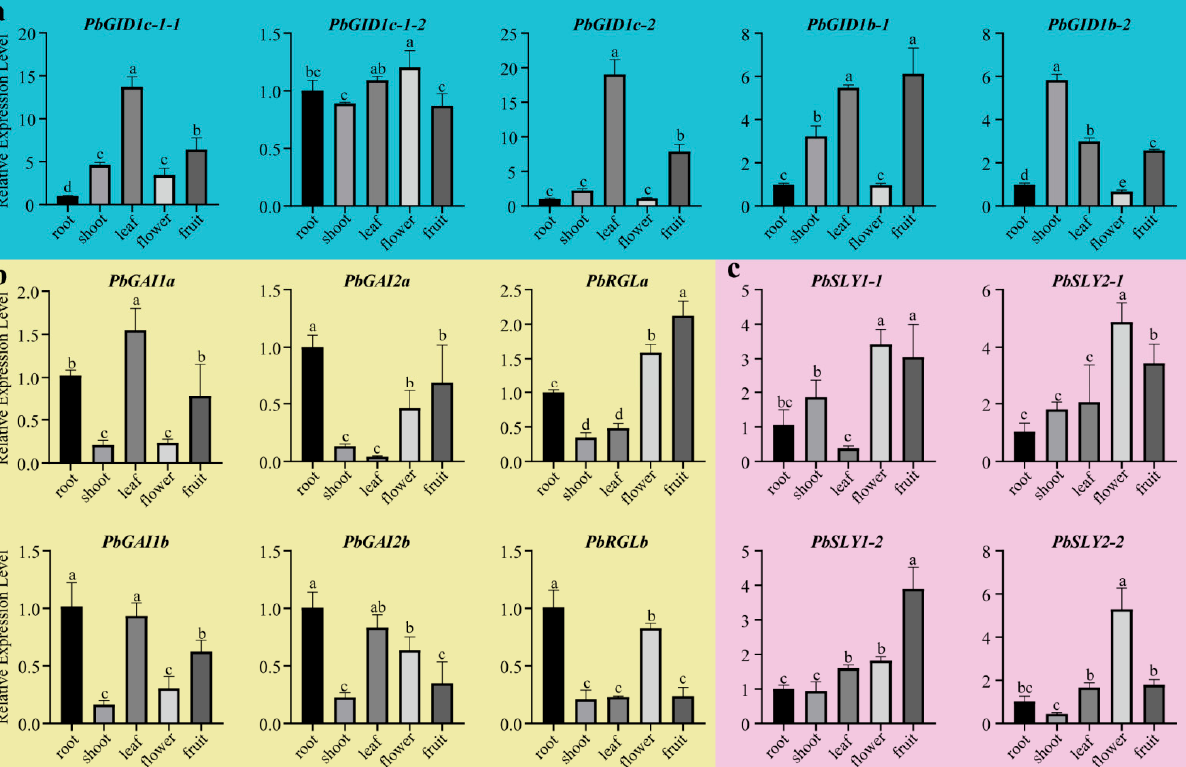
Figure 6. Expression profiles of PbGID1 , PbDELLA , and PbSLY family genes in different tissues of ‘duli’ pear ( Pyrus betulifolia Bunge). ( a ) Expression profiles of PbGID1s (shaded blue). ( b ) Expression profiles of PbDELLAs (shaded yellow). ( c ) Expression profiles of PbSLYs (shaded lilac). Quantitative RT-PCR was carried out using total RNA isolated from different tissues as indicated. PbACTIN was used as the reference gene. The relative expression level of each gene was calculated relative to the transcript level of the roots (set as 1). Each bar represents the mean ± SE ( n = 3). Different letters above the bars indicate significant differences at p < 0.05 ( n = 3) analyzed by Duncan’s multiple range